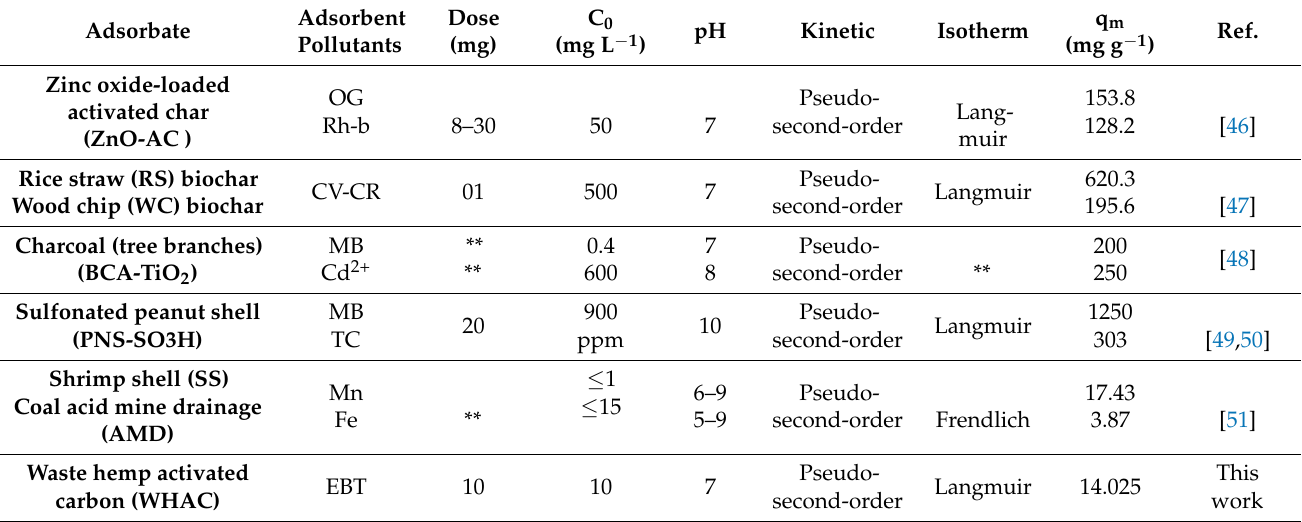
Table 3. The adsorption capacity of dyes and heavy metals in aqueous solutions by activated carbons of different